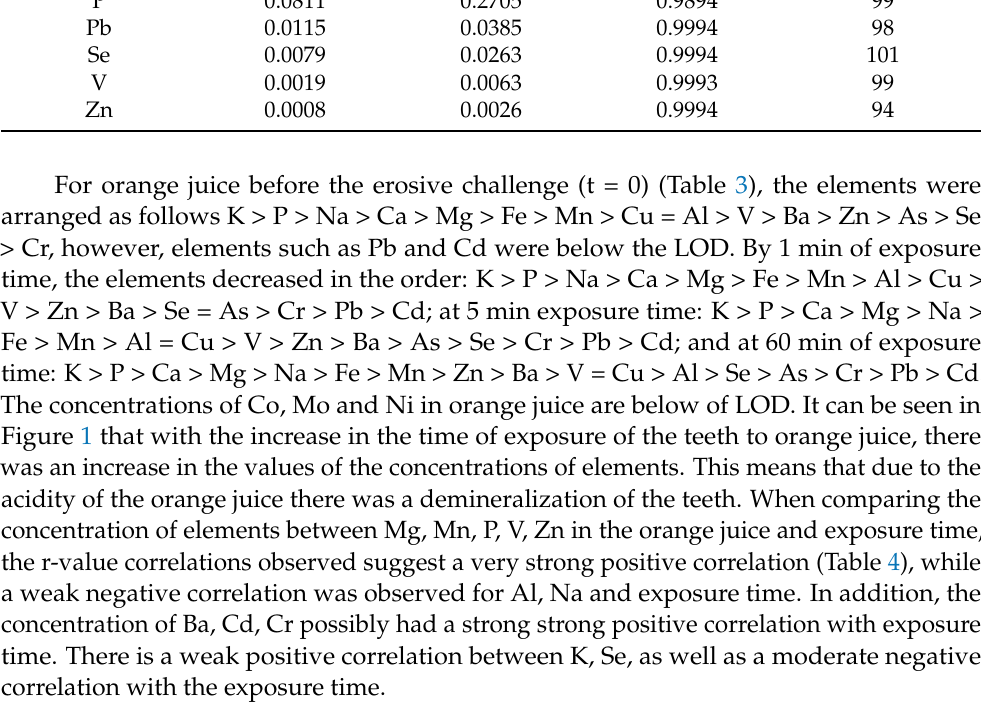
Table 2. Analytical data obtained by the ICP OES: limit of detection (LOD), limit of quantification (LOQ), correlation coefficient ( R 2 ), and percentage of recovery (%). Elements LOD (mg/L) LOQ (mg/L) ( R 2 ) Recovery (%) Al 0.0633 0.2110 As 0.0056 0.0185 Ba 0.0008